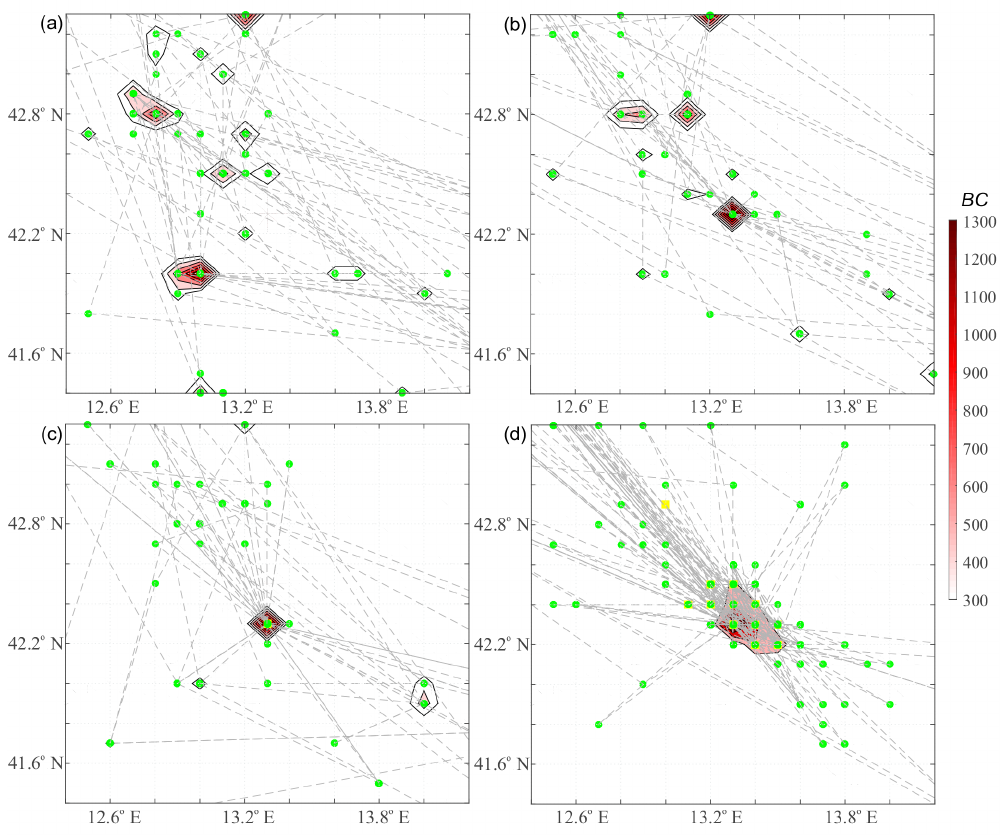
Figure 9. Snapshots of seismic networks overlaid on the BC contours for R 1 = 3 ◦ around the epicenter; green squares correspond to events of M ≤ 3 . 0, while yellow squares correspond to events of 3 . 1 ≤ M ≤ 5 . Dash lines are the edges of the network that connect successive seismic events. The time window for each network is 15 days. (a) From 26 September until 10 October 2008, (b) from 14 to 27 January 2009, (c) from 20 March to 4 April 2009 and (d) from 1 to 16 April